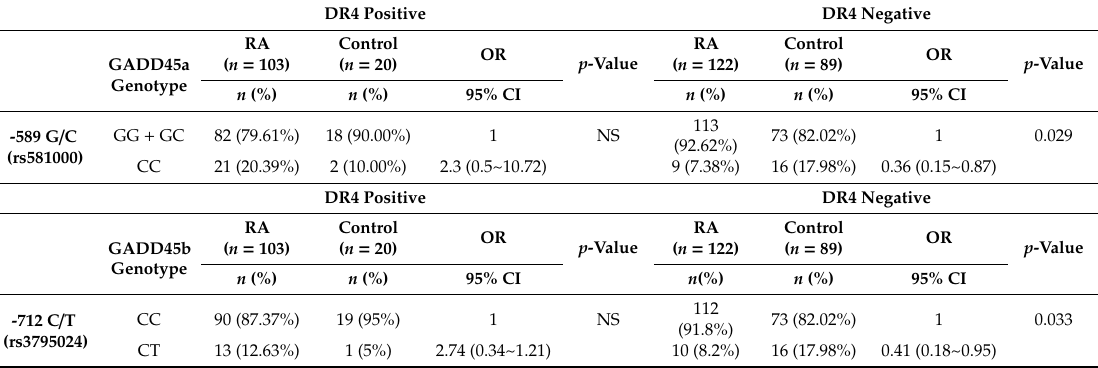
Table 4. Genotype frequency of -589G / C GADD45a, -712C / T GADD45b in DR4-positive and DR4-negative RA